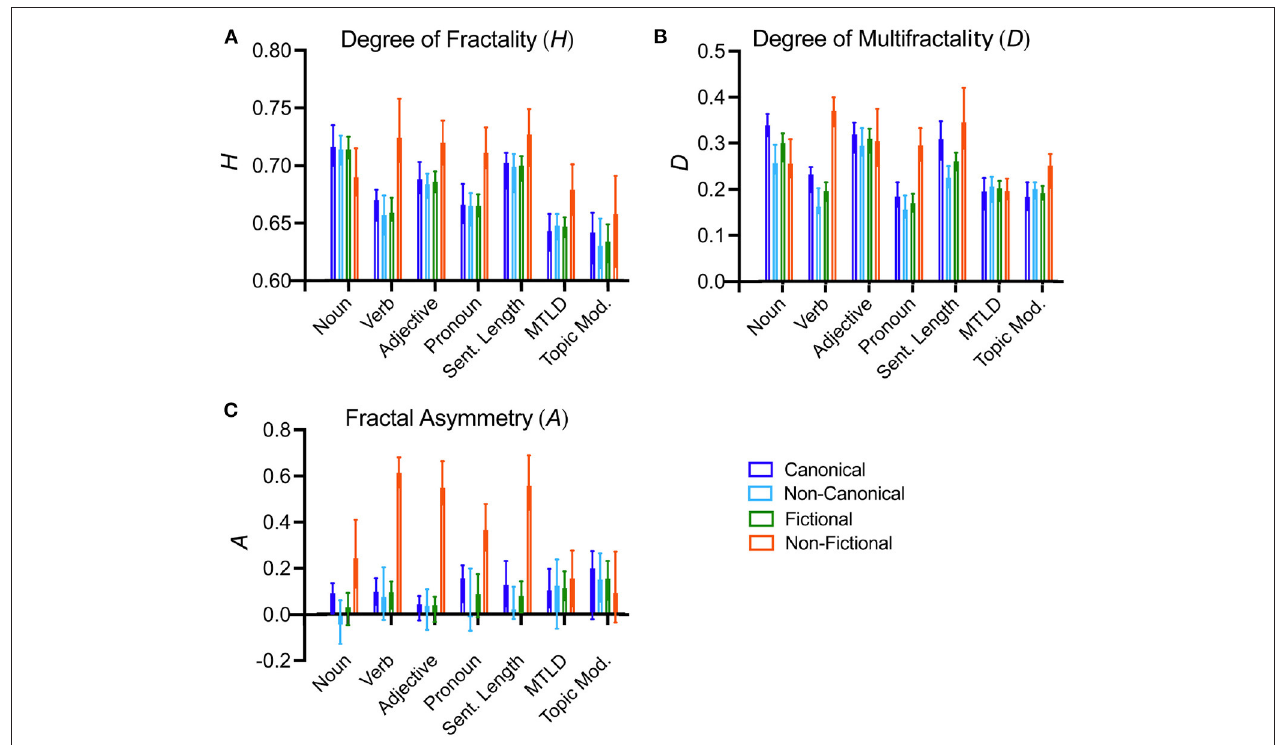
FIGURE 5 | Plots of the median values for the degree of fractality (A) , the degree of multifractality (B) , and fractal asymmetry (C) for all text properties. The colors indicate the different text categories, as indicated on the down right of the figure. The whiskers indicate 95% confidence intervals. For significances of the differences, see Table 2 . Sent. Length, sentence length; Topic Mod., topic